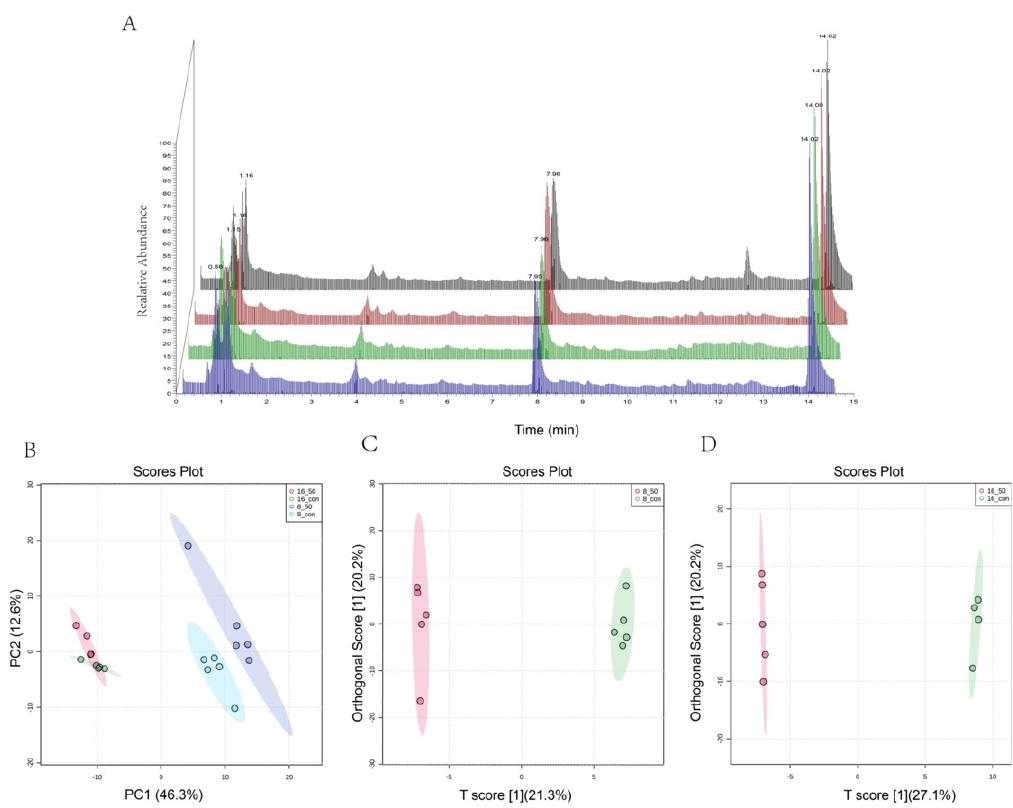
Figure 4. Comparative analysis of intracellular metabolites in L. plantarum CCFM1287 during PAT exposure. Total ionogram (TIC) plots for each treatment group ( A ). Control group 8 h (red), PAT group 8 h (blank), control group 16 h (green), and PAT group 16 h (blue). PCA of the PAT exposure and control groups in the 8 and 16 h treatment groups ( B ). The OPLS-DA of the PAT-exposure and control groups with 8 h of reaction time ( C ), and in the 16 h of reaction time ( D ). Results are shown as the mean of four or five replicates.